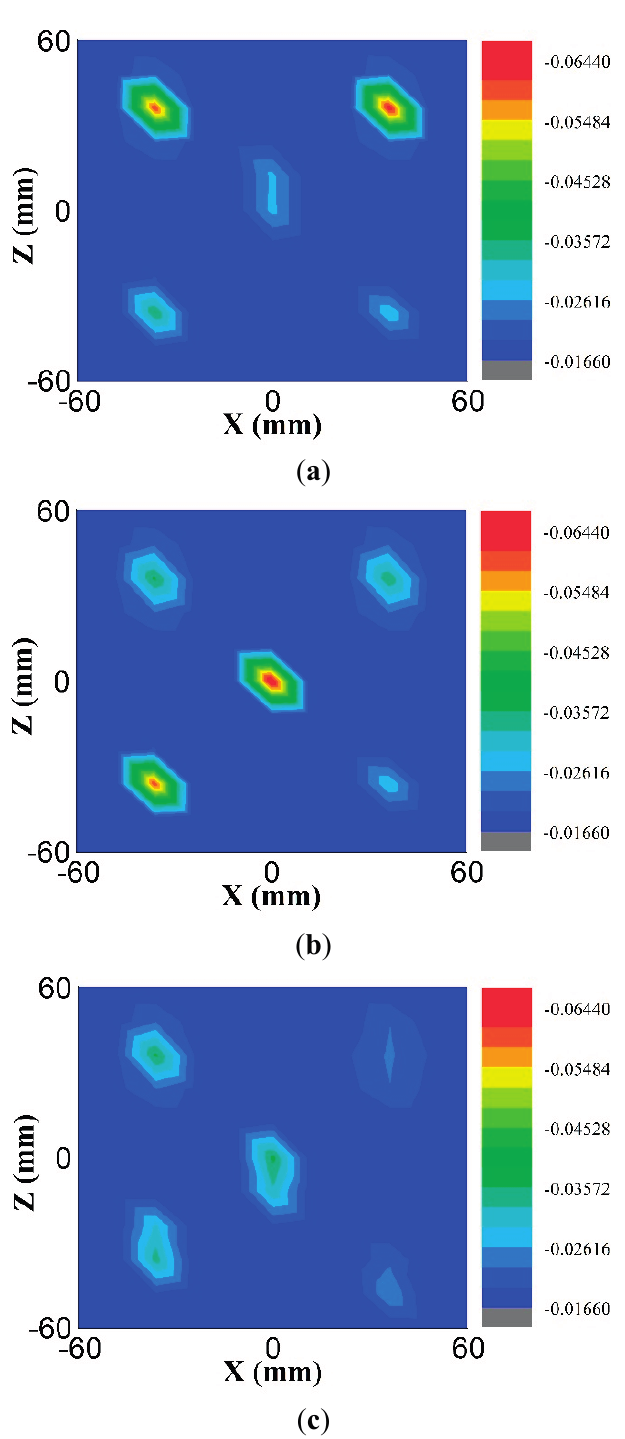
Figure 24. The simulated cal S ( c ) 8.8